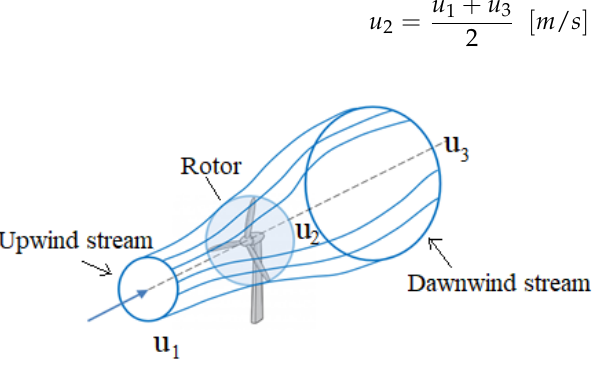
Figure 1. Representation of upwind and downwind stream for wind